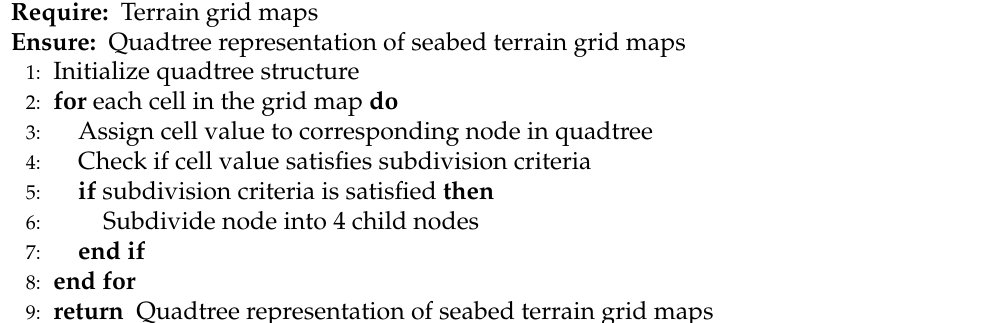
Algorithm 3 Quadtree representation of seabed terrain grid maps